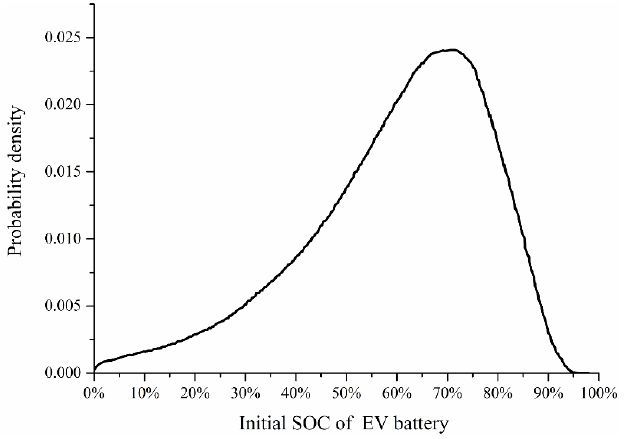
Figure 4. The probability distribution of initial battery